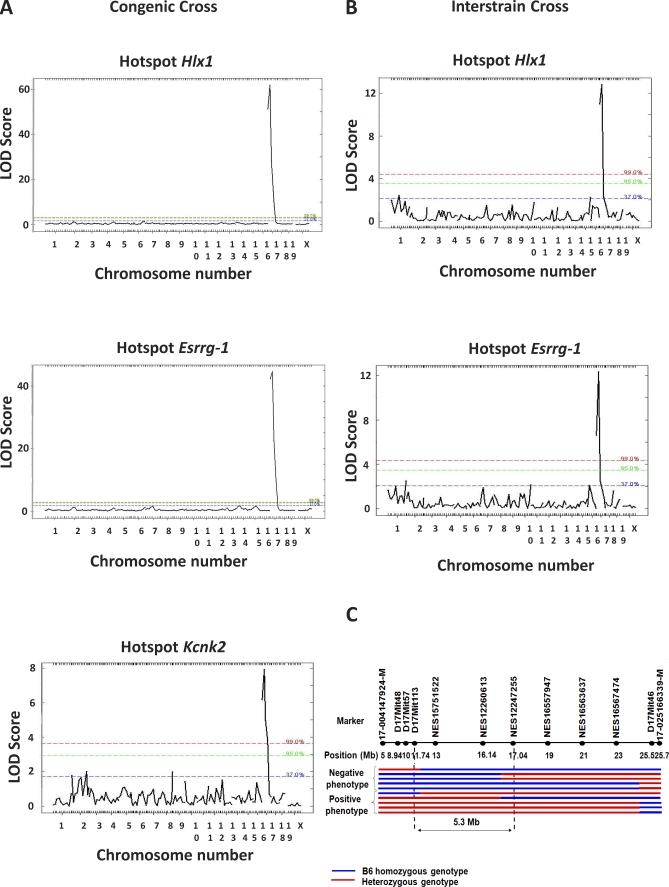
QTL Analysis of Phenotyping and Genotyping Data(A) A total of 211 samples from the first mapping and (B) 98 samples from the second mapping cross were used in the analysis. The LOD scores are the result of 10,000 permutations per analysis.(C) Further mapping on Chr 17 of recombinants in the interval 5–25 Mb, including eight recombinants from the congenic backcross and two from the interstrain cross. The borders of the critical region within which Rcr1 must lie are marked with dashed vertical lines.